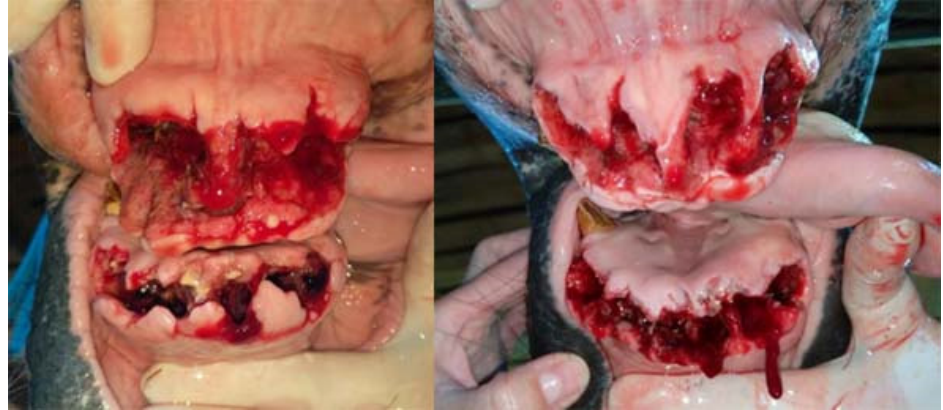
Figure 10. The condition of the tooth extraction sockets immediately after the extraction (on the left—case 1, on the right—case 2).